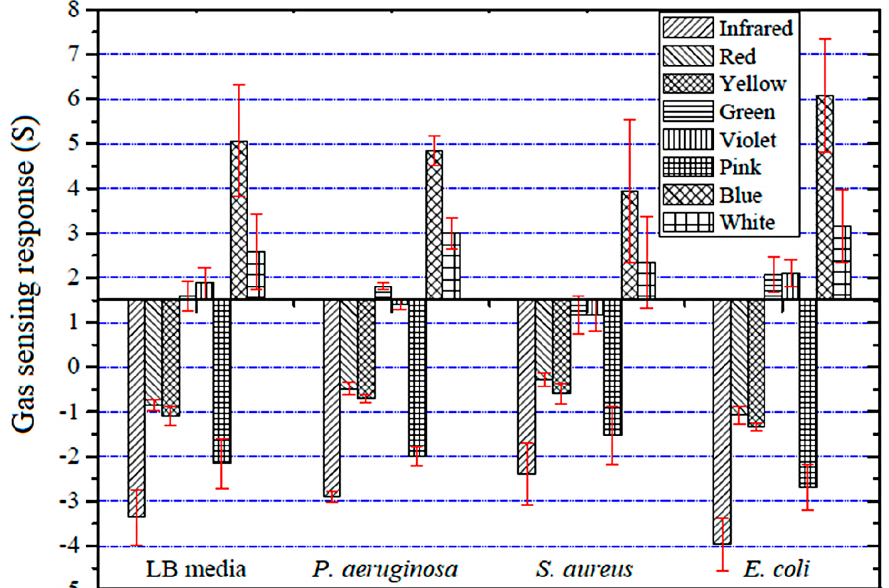
Figure 8. The gas sensing response (S) of the thermally treated optical gas sensor toward three species of bacteria in culture media after 9 h of incubation.